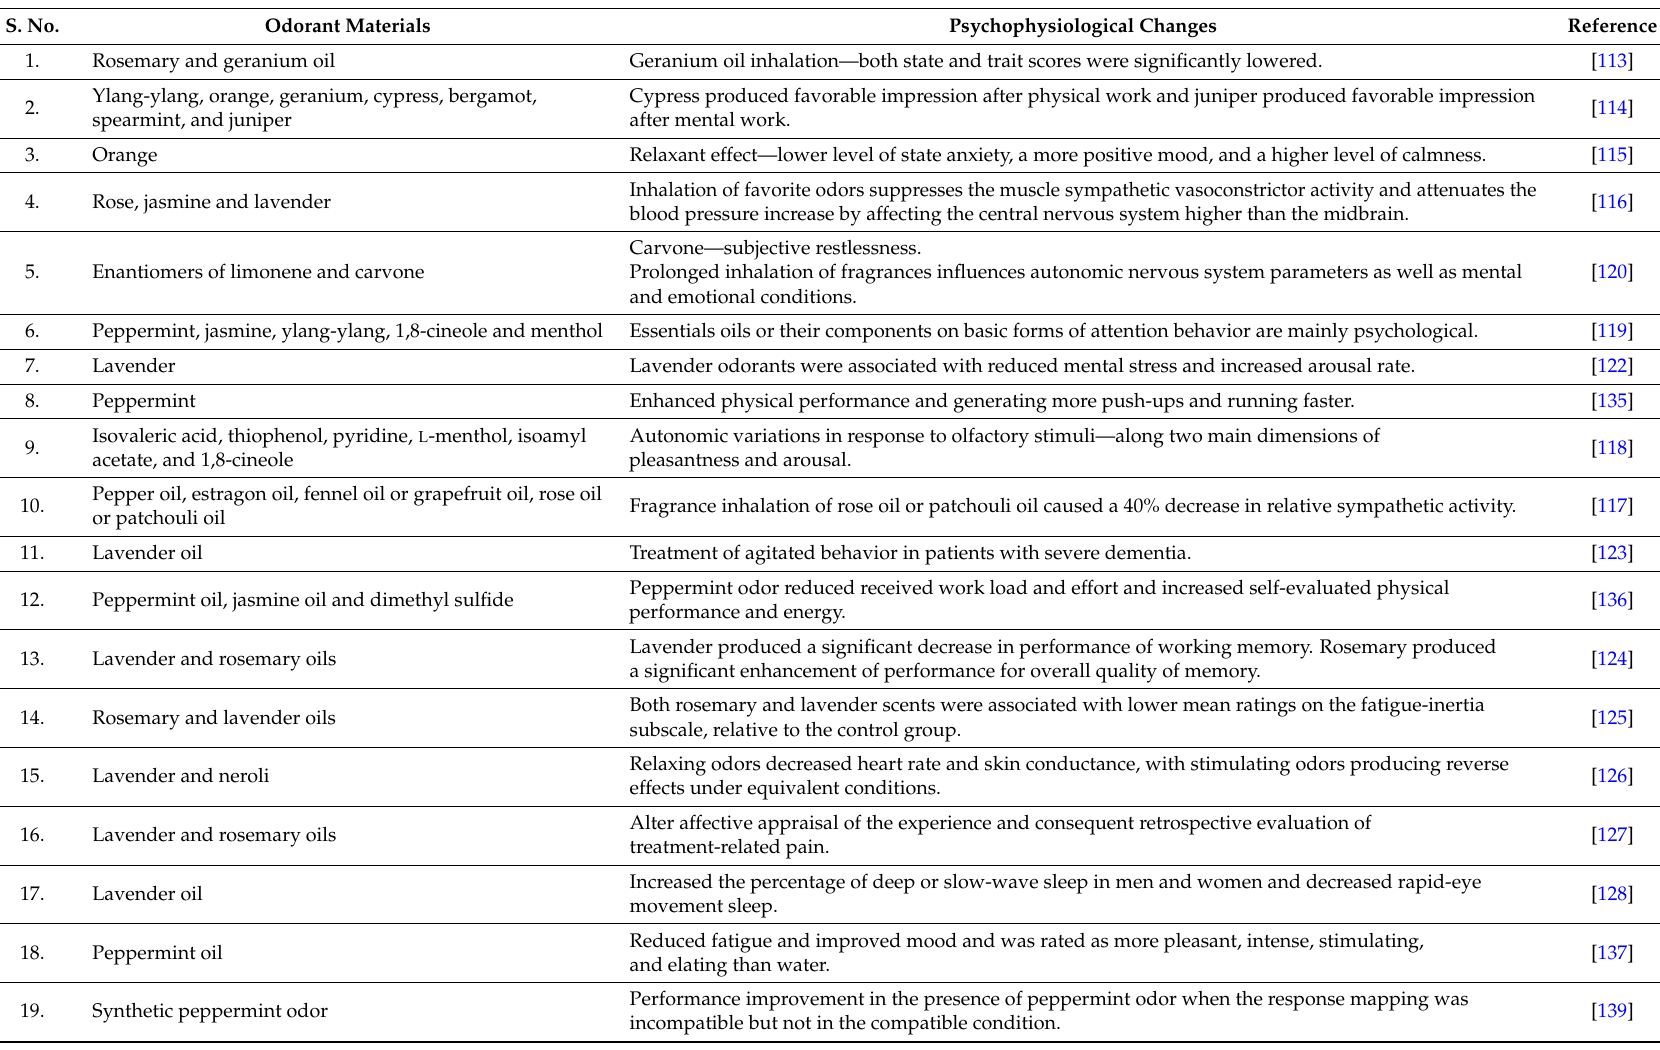
Table 3. Effect of inhalation of aroma on psychophysiological functions of